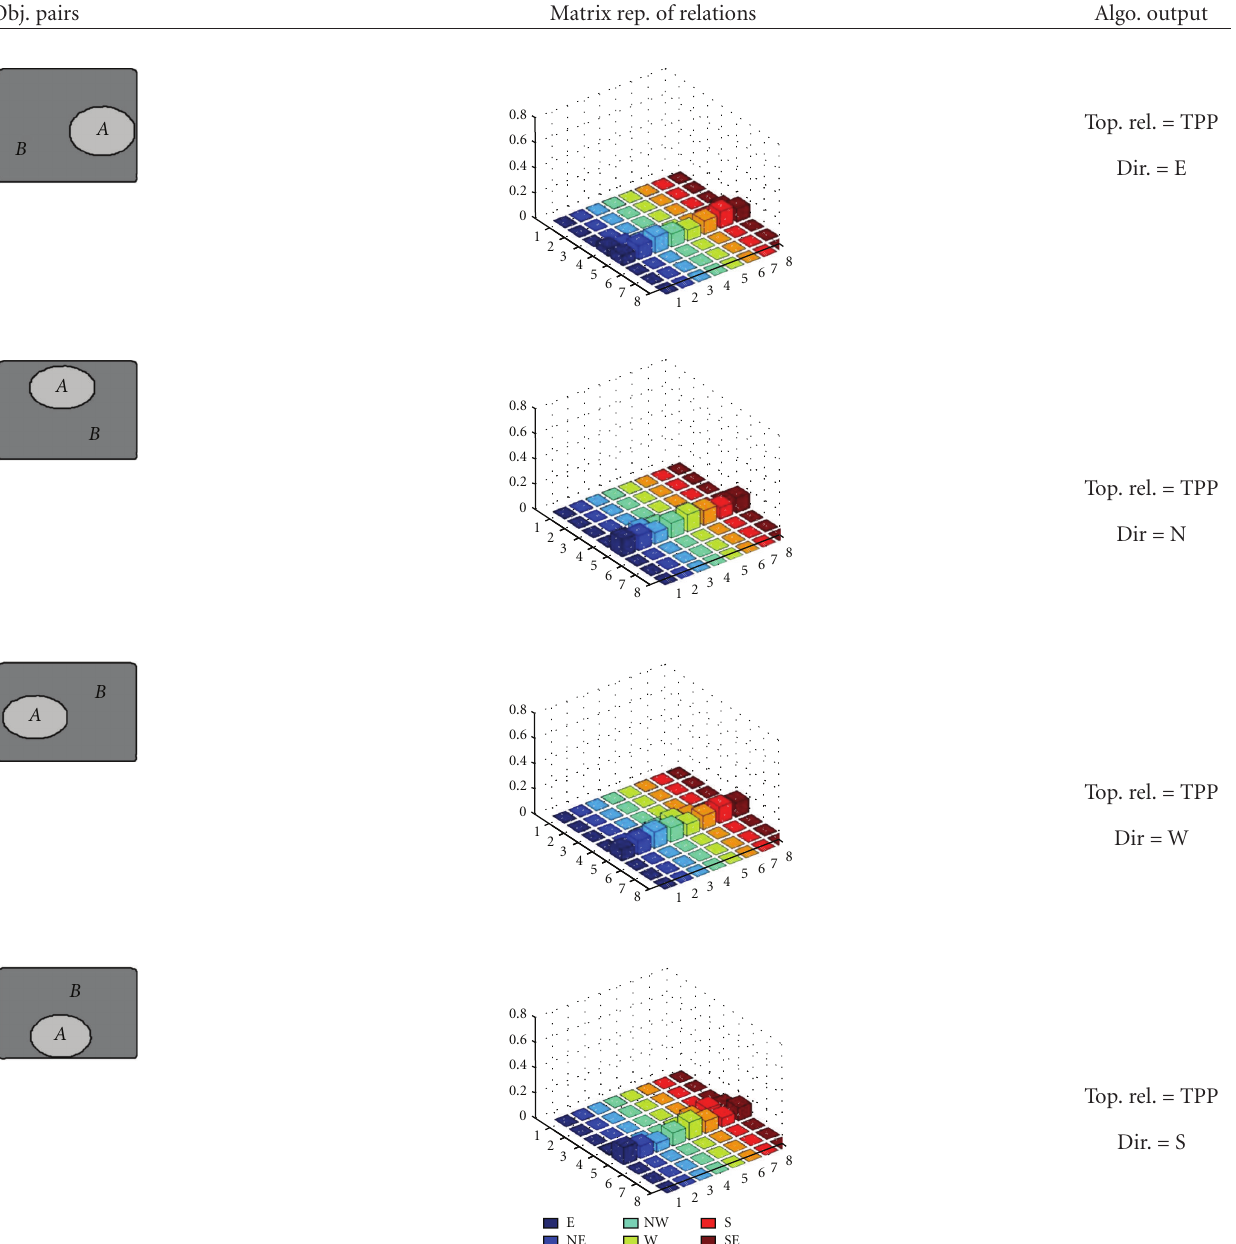
Top. rel. = TPP Dir. =